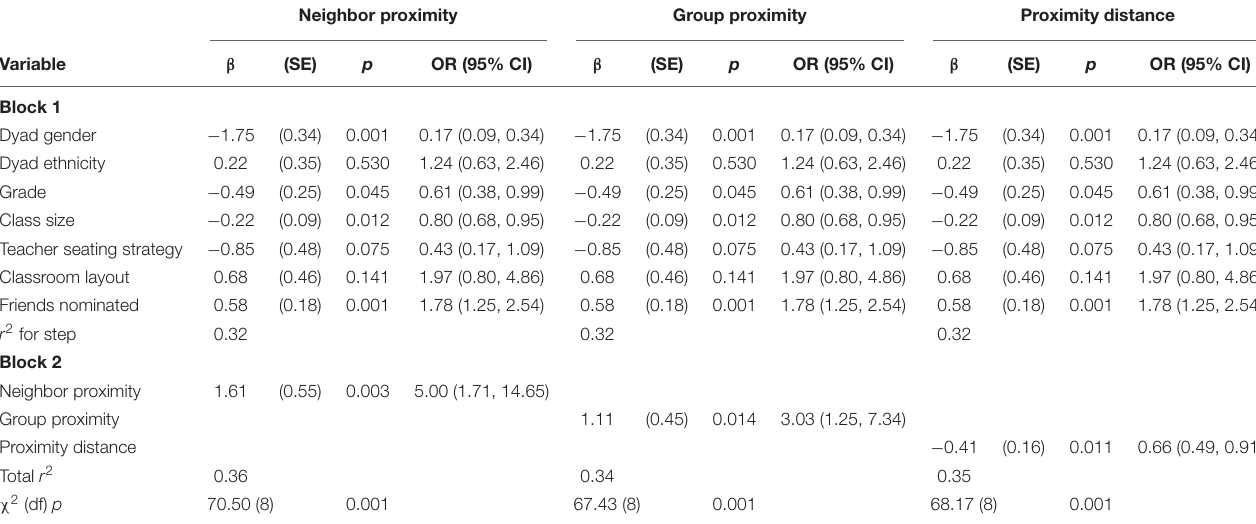
TABLE 1 | Concurrent logistic regressions predicting Time 1 outgoing friend nominations from Time 1 classroom seating: One randomly selected nomination per student. Neighbor proximity Group proximity Proximity